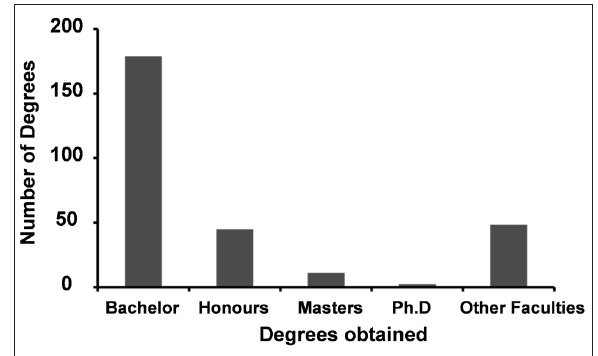
Degrees obtained at the University of the Free State by students who started in the Natural Sciences Stream of the University Preparation Programme over the period